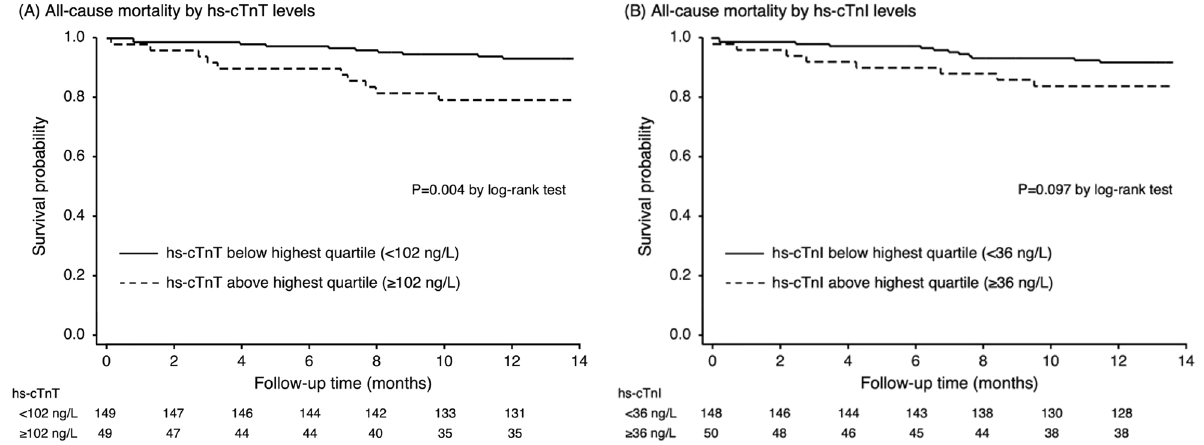
Figure 1. Kaplan–Meier survival curve analysis for all-cause mortality in patients above or below the highest quartile of hs-cTnT ( A ) and hs-cTnI ( B ).